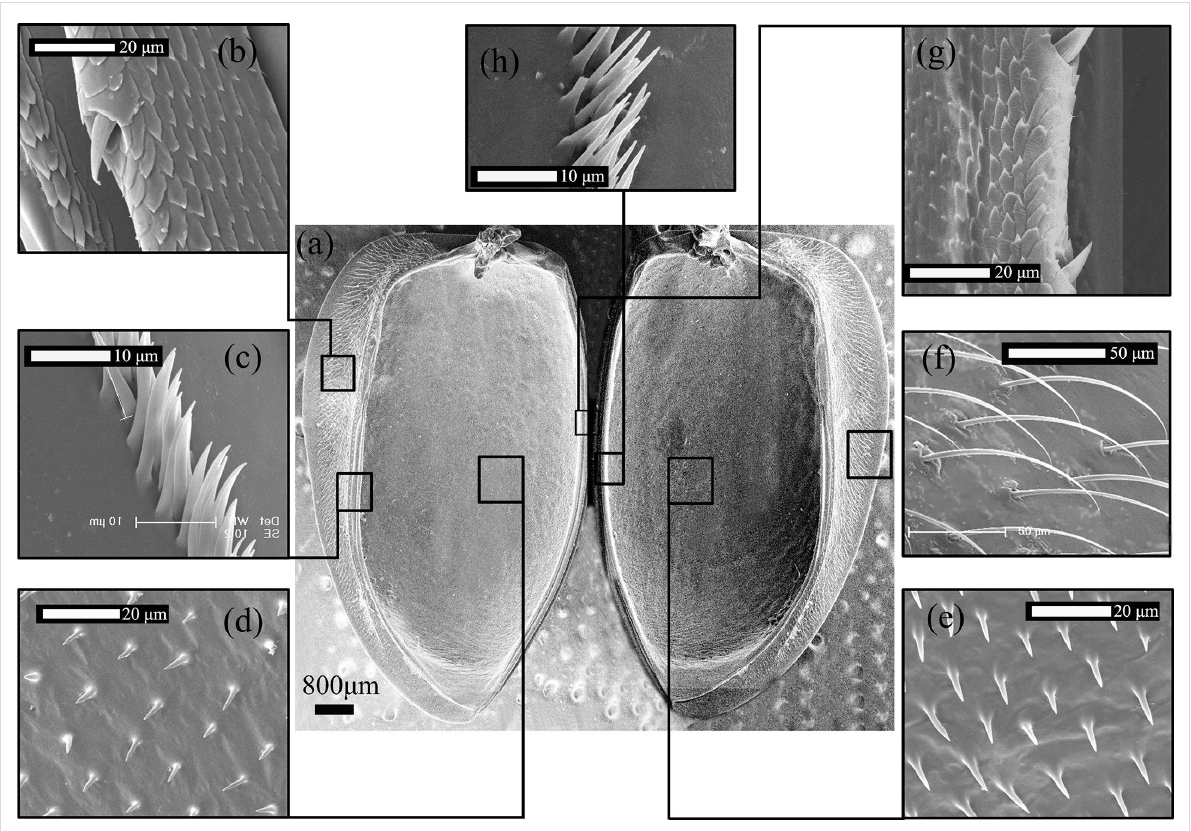
Figure 3: (a) A SEM photograph of the ventral side of H. axyridis elytra; (b, g) the second-level microtrichia and lateral binding patches on the elytra, respectively; (c, h) the third-level microtrichia and sutural binding patches on the elytra; (d, e) the fourth-level microtrichia and patches of small spicules; and (f) the first-level microtrichia with a patch of long